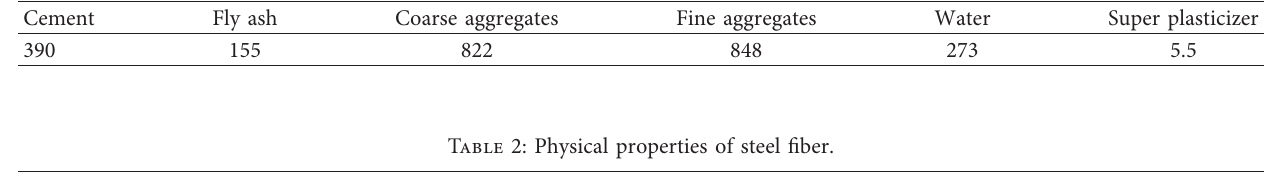
Table 1: Basic mix proportion of the concrete (kg/m 3